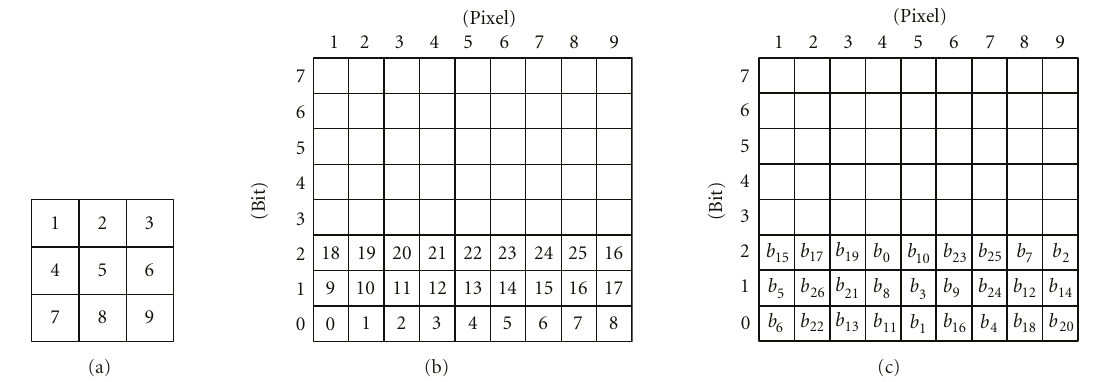
Figure 3: An example of embedding a 27-bit watermark b in a 3 × 3 block: (a) the arrangement of the 9 pixels, (b) the arrangement for the 3-LSBs of the 9 pixels, (c) the result of